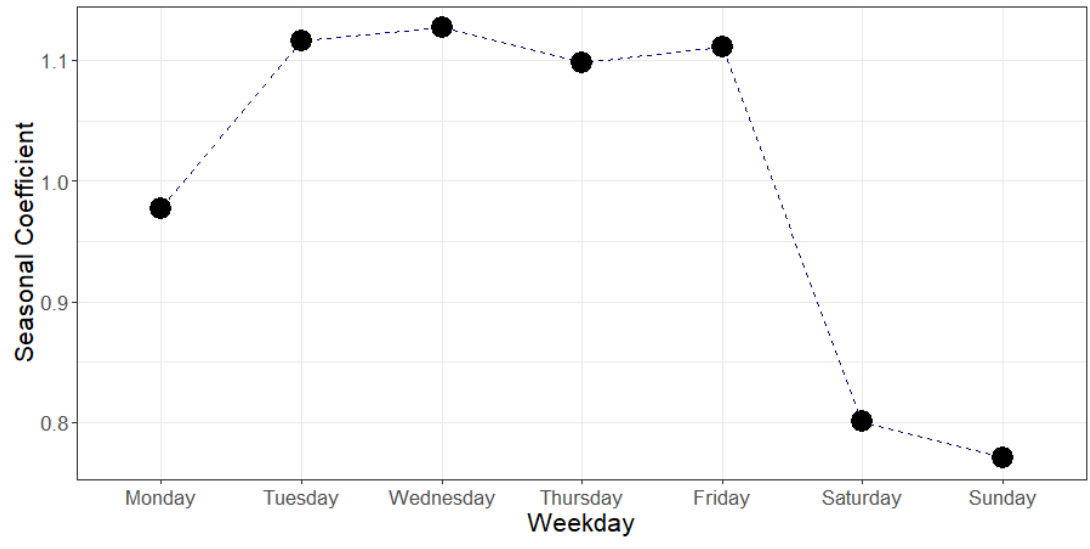
Fig. 5. Multiplicative seasonal coefficients for the daily trading volume on different